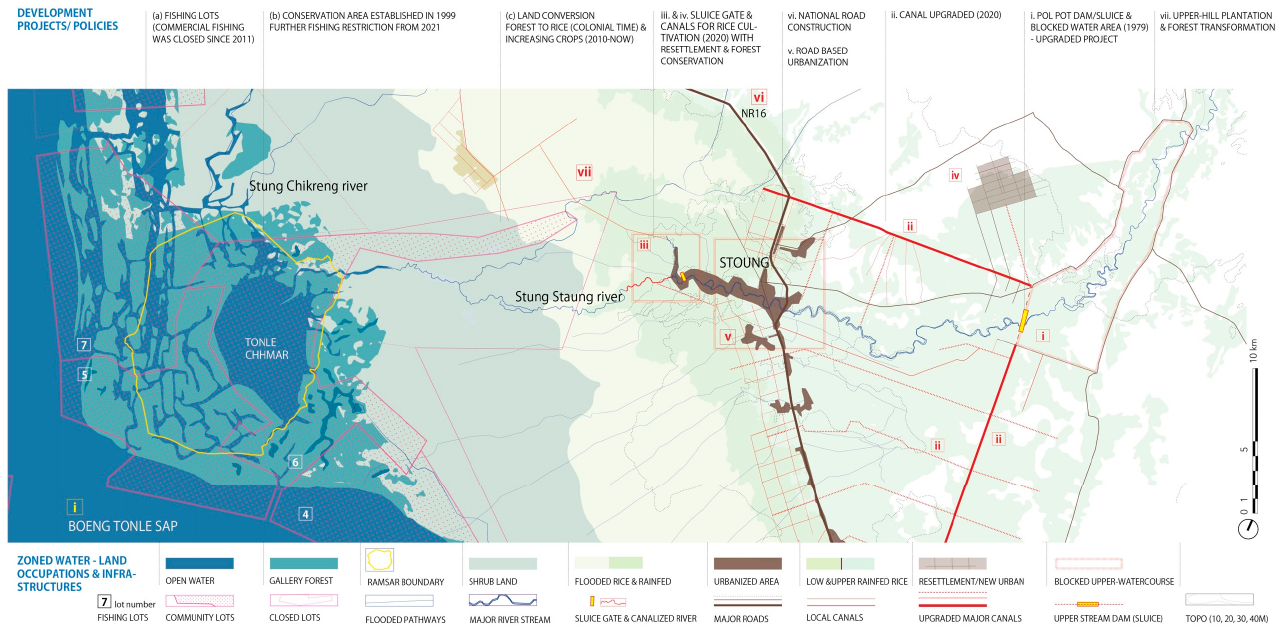
Figure 12. The Boeng Chhmar − Stung Staung River catchment transect (see location indicated on Figure 1). The natural geometries of the lake’s nature contrast sharply with the human − made system of infrastructure and agricultural land areas. The transformation adversely effects the forest water regimes, habitats, and local livelihoods of Boeng Chhmar (Linh Vu, 2022 from GIS open source, Google Maps).